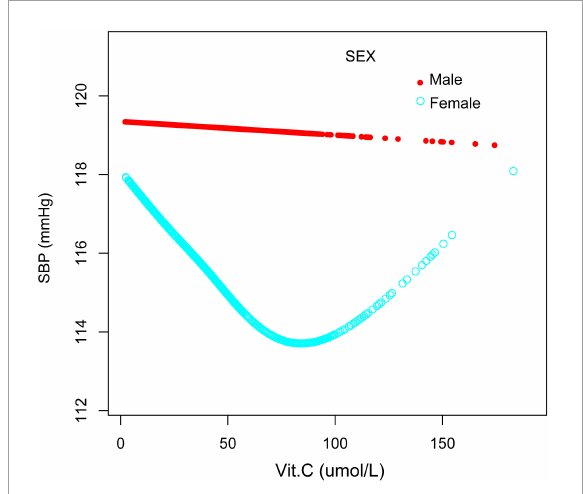
FIGURE4 The relationship between vitamin C and SBP, stratified by sex. Age, race/ethnicity, marital status, education level, ratio of family income to poverty, BMI, smoking states, pulse, ALT, ALP, AST, BUN, globulin, Cr, TG, TC, LDL, HDL, glycohemoglobin, TP, FBG, γ GT, and sUA were adjusted.